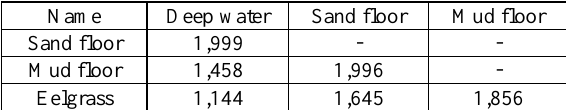
J-M distances computed with the class training areas delineated from the PCI Geomatica RGB mosaic of Shediac Bay for each class (eelgrass, deep water, sand, and unknown dark areas).